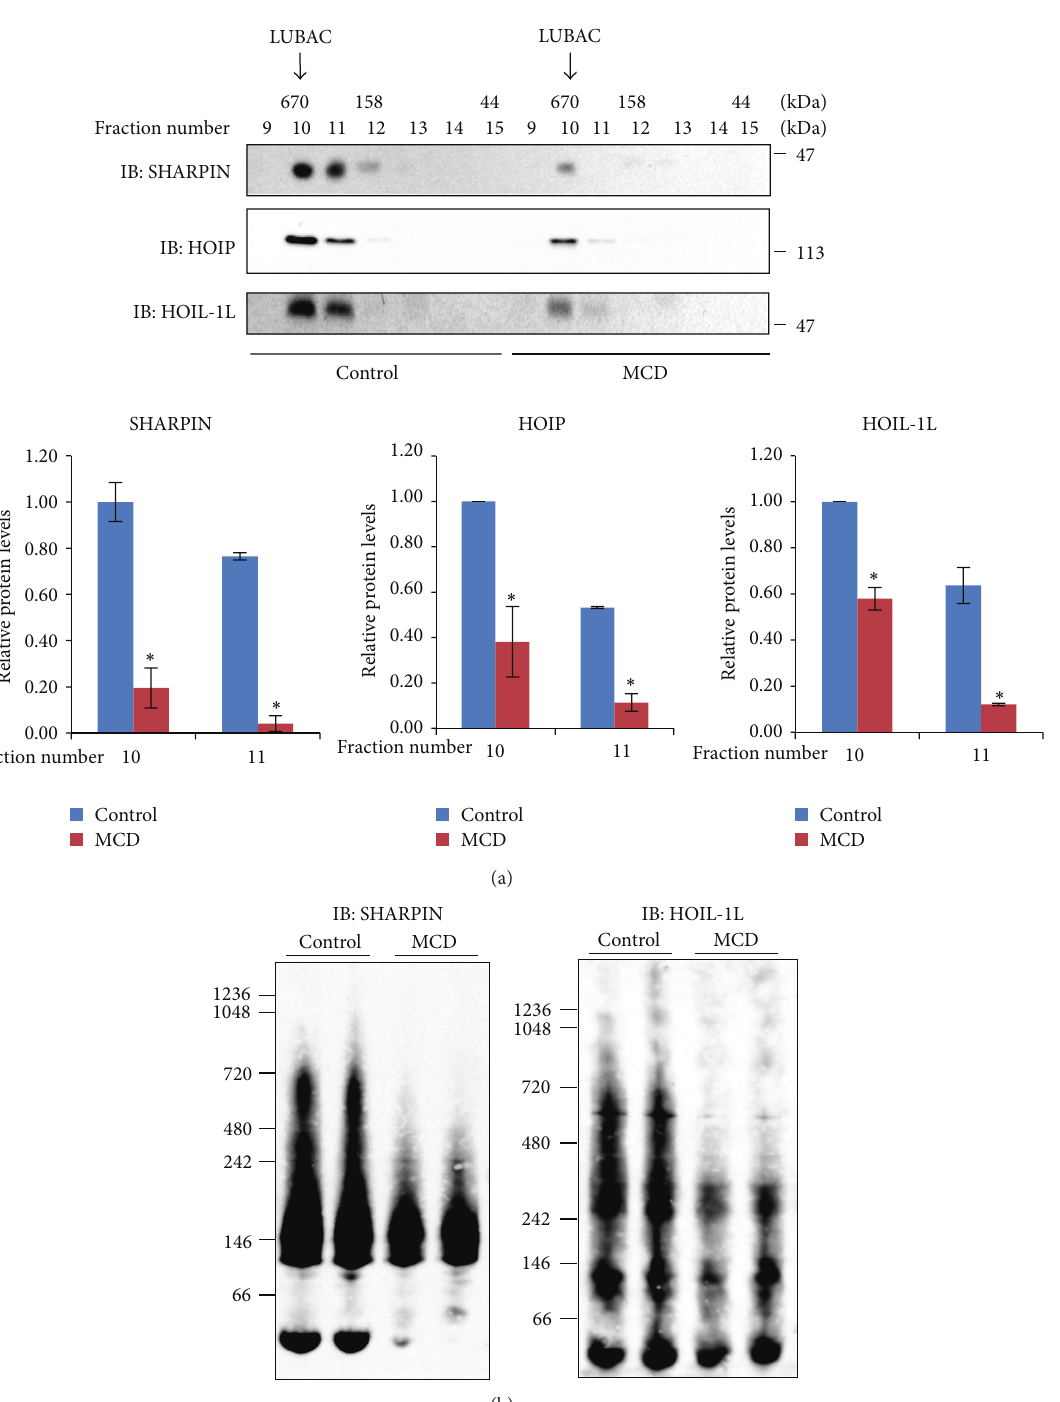
Figure 2: Eight-week-old mice were fed the control or the MCD diet for 8 weeks. Their livers were removed and LUBAC formation was investigated. (a) The liver cell lysates were subjected to gel filtration. Each fraction was analyzed by western blotting with anti-HOIP, anti- HOIL-1L, or anti-SHARPIN antibody. (b) The liver cell lysates were subjected to Blue Native-PAGE without SDS, followed by western blotting with anti-HOIL-1L or anti-SHARPIN antibody. The immunoblotting data are representative of three to five independent